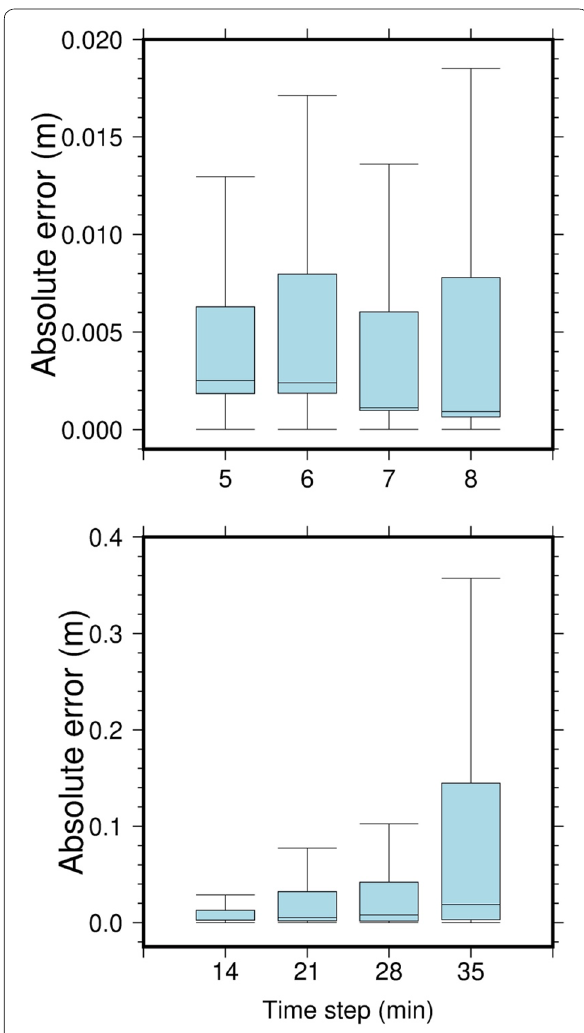
Fig. 11 Box and whiskers plots indicating the absolute error between the proposed method and DA for the 2011 Tohoku